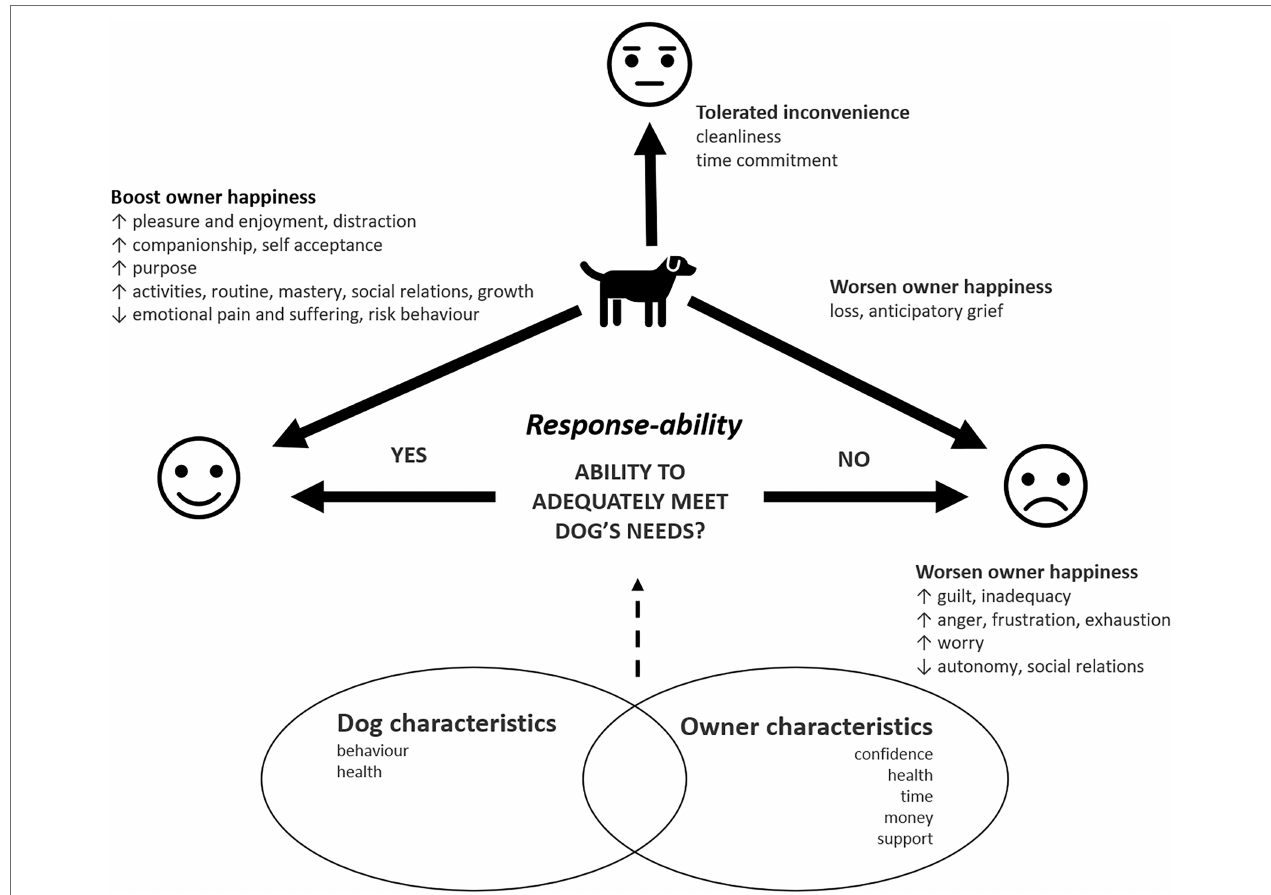
FIGURE 1 | Thematic model of positive and negative impacts of dog ownership on owner wellbeing from qualitative analysis of open-text